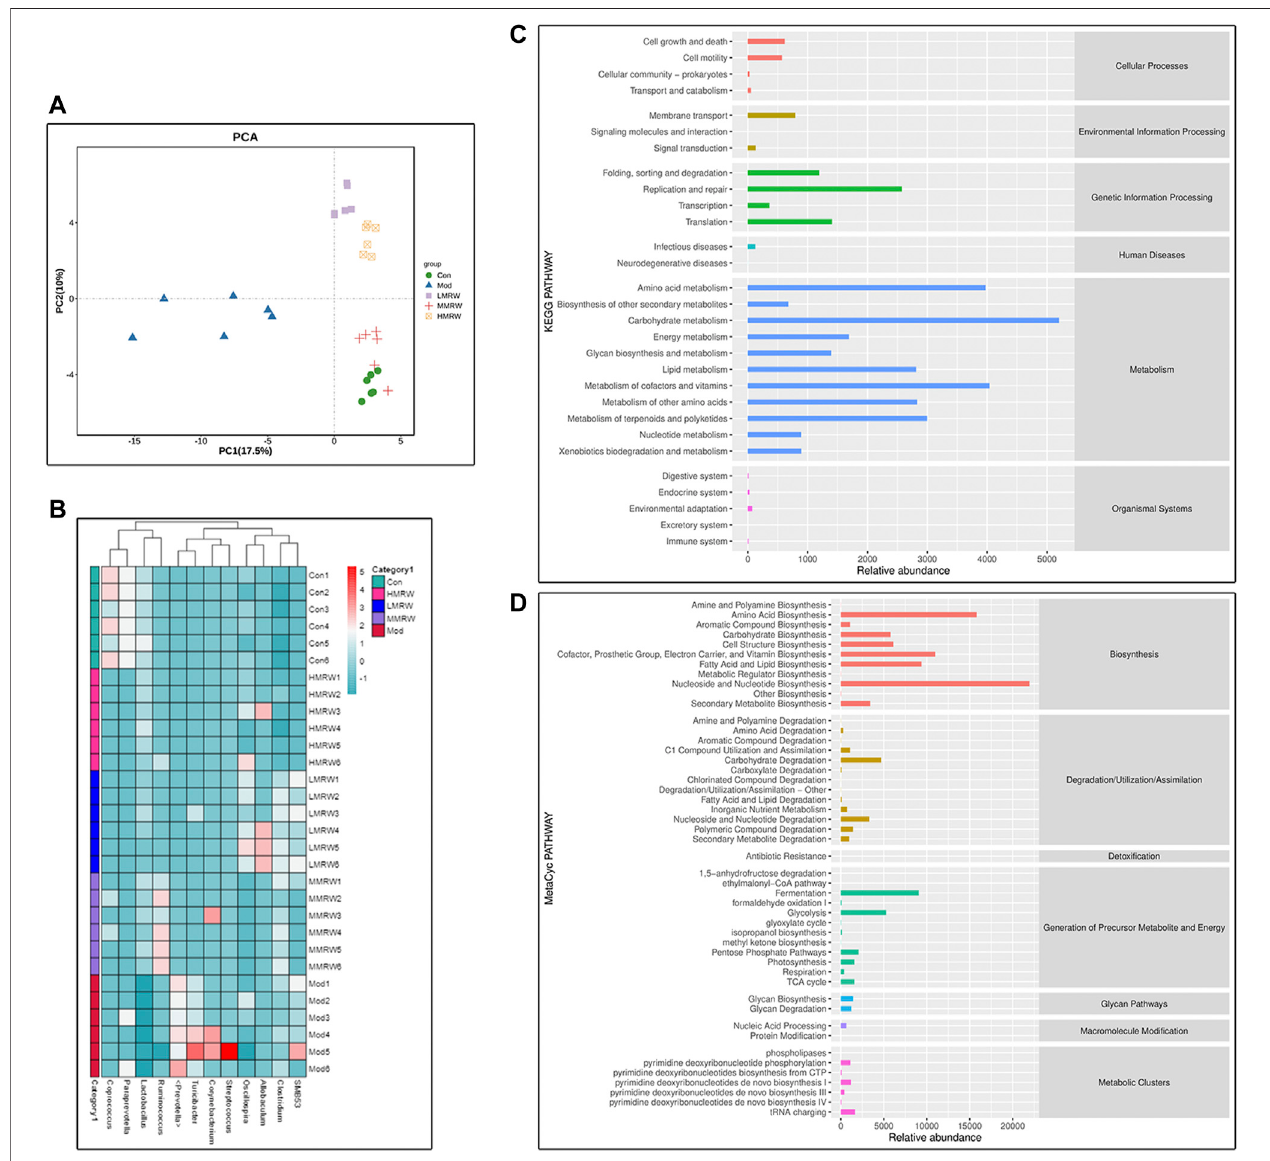
FIGURE4| Similarityanalysisofthecolonicmicrobialstructureandpotentialmicrobialpathwayanalysisofcolonicmicro fl ora. (A) PCA. (B) Heatmapofgeneralevel community composition. (C) KEGG results. (D) MetaCyc results. Con: control group, Mod: model group, L-MRW: low dose of MRW group, M-MRW: medium dose of MRW group, and H-MRW: high dose of MRW